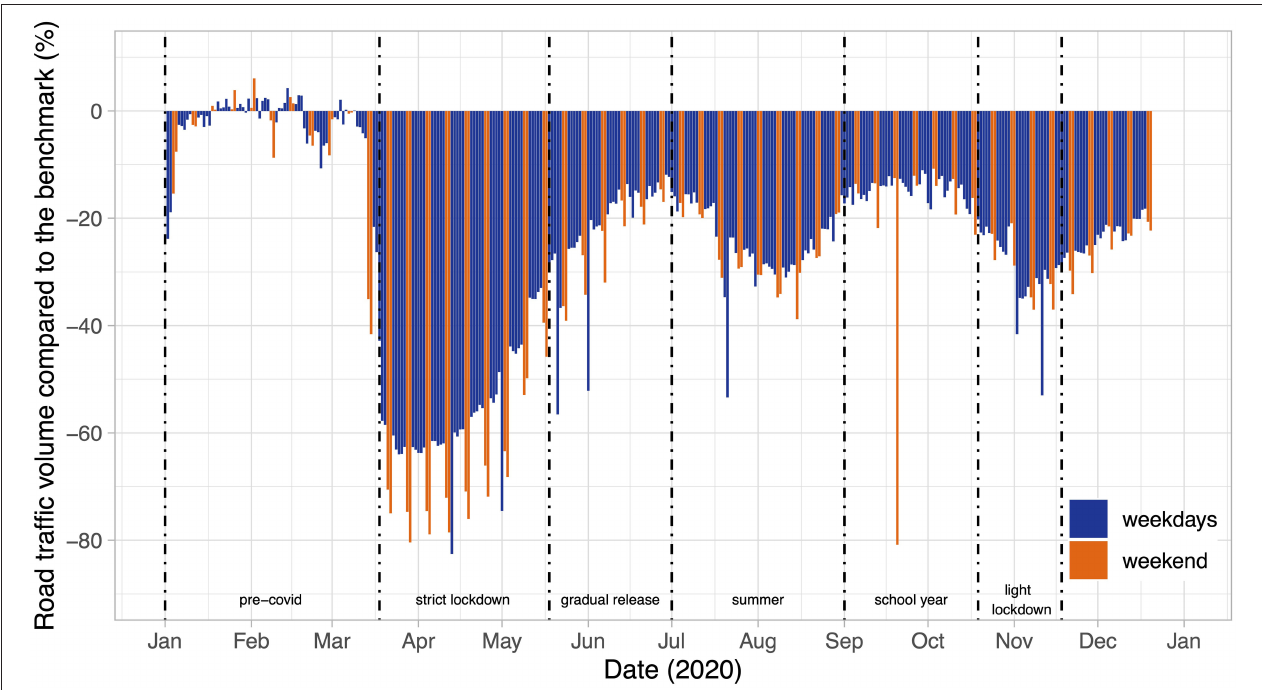
FIGURE 1 | Evolution of road traffic levels in the Brussels Capital region in 2020 compared to the pre-lockdown benchmark (data source: Brussels Mobility). Outliers includes car-free Sunday on September 20 and some public